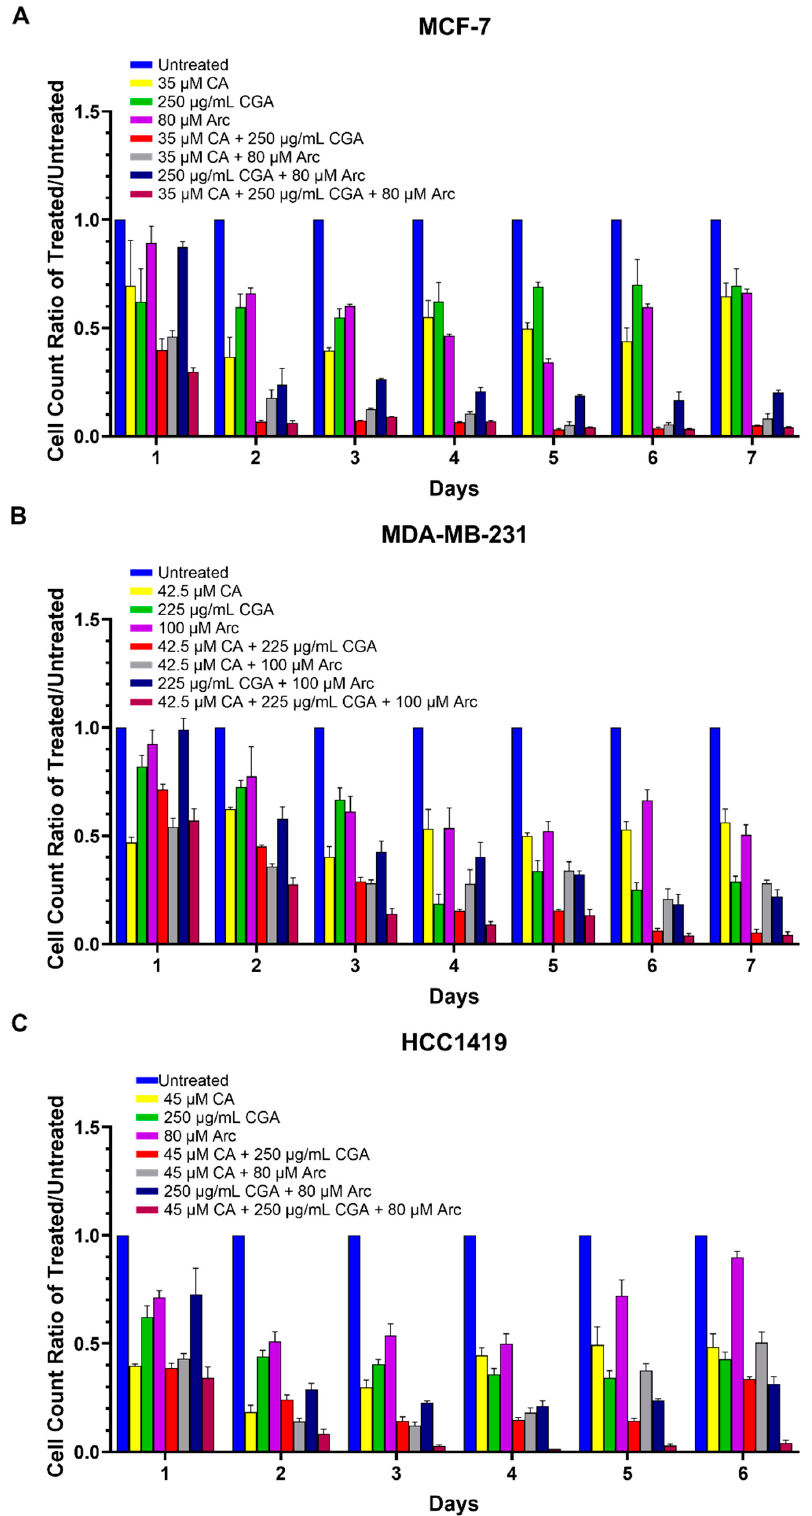
Figure 3. Ratios of cell numbers of each treatment group to the untreated group in ( A ) MC7-7, ( B ) MDA-MB-231, and ( C ) HCC1419 breast cancer cells. Each bar represents the mean ± SEM of three biological replicates ( n = 3). The treatment groups were compared using a one-way ANOVA. The results of the statistical analysis are summarized in Tables S4–S6. Cell growth differences between treatment groups were considered significant at p ≤ 0.05.